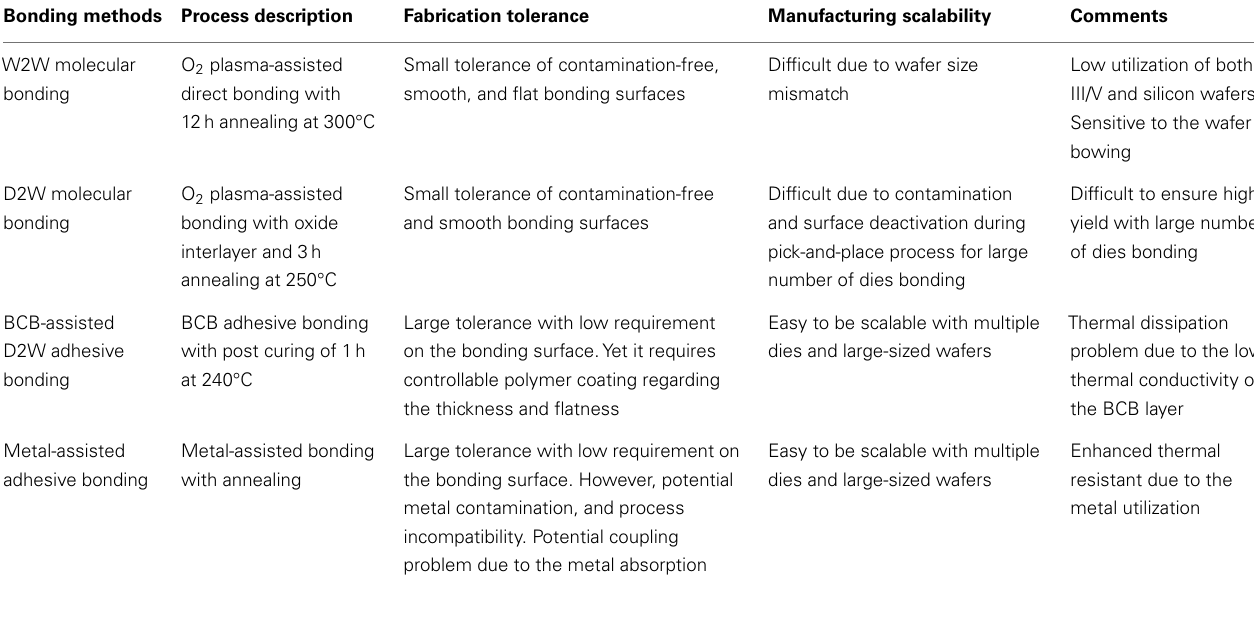
Table 2 |The major bonding technology for hybrid integration